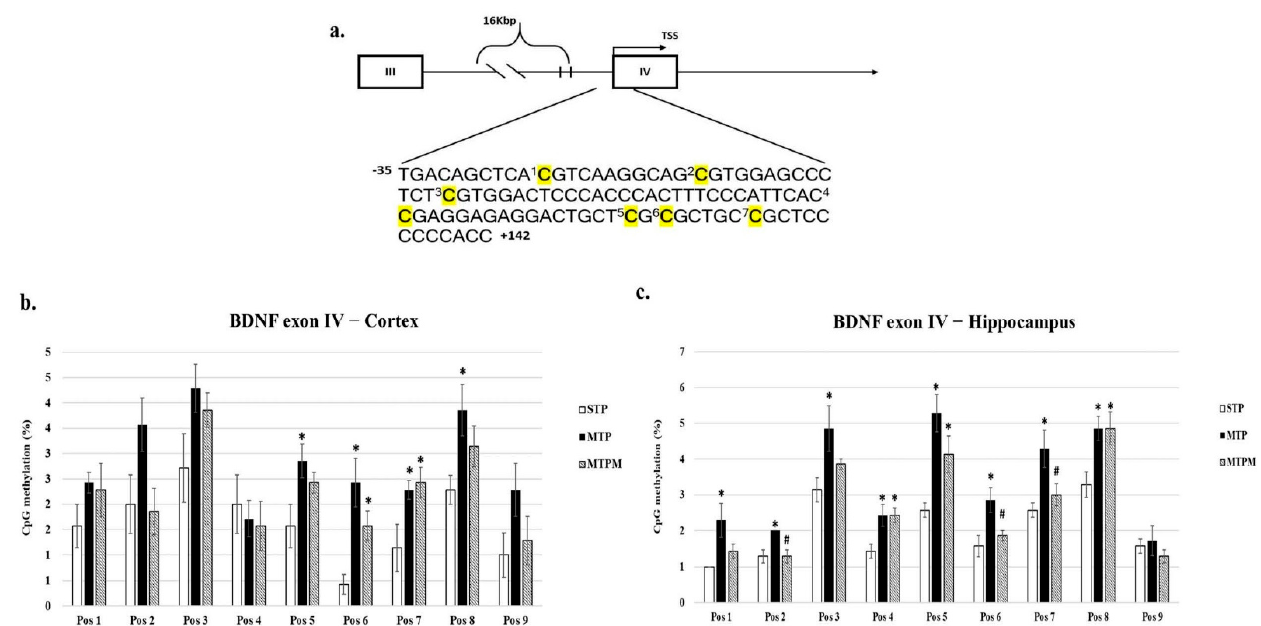
Figure 2. MTX treatment stimulated the alteration of CpG methylation status in BDNF exon IV promoter while melatonin attenuated the alteration resulted from MTX. ( a ) Scheme of BDNF exon IV promoter region for pyrosequencing. CpG positions are highlighted in yellow background. ( b ) Methylation status in different CpG sites of BDNF exon IV promoter in brain cortex. ( c ) Methylation status in different CpG sites of BDNF exon IV promoter in hippocampus (* p < 0.05 vs. STP; # p < 0.05 vs. MTP). “C” highlights in bold with yellow background indicate variable CpG positions.